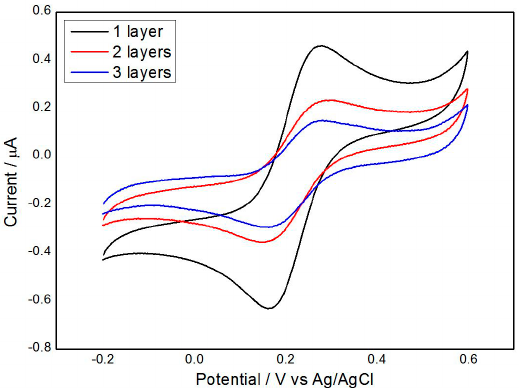
Figure 6. The representation of self-assembled graphene layers of the Gr/ L -cysteine/gold microelectrode (all of the microelectrodes diameters were designed to yield 3 mm, and each graphene layer was modified by 3 µL of carboxylic graphene).